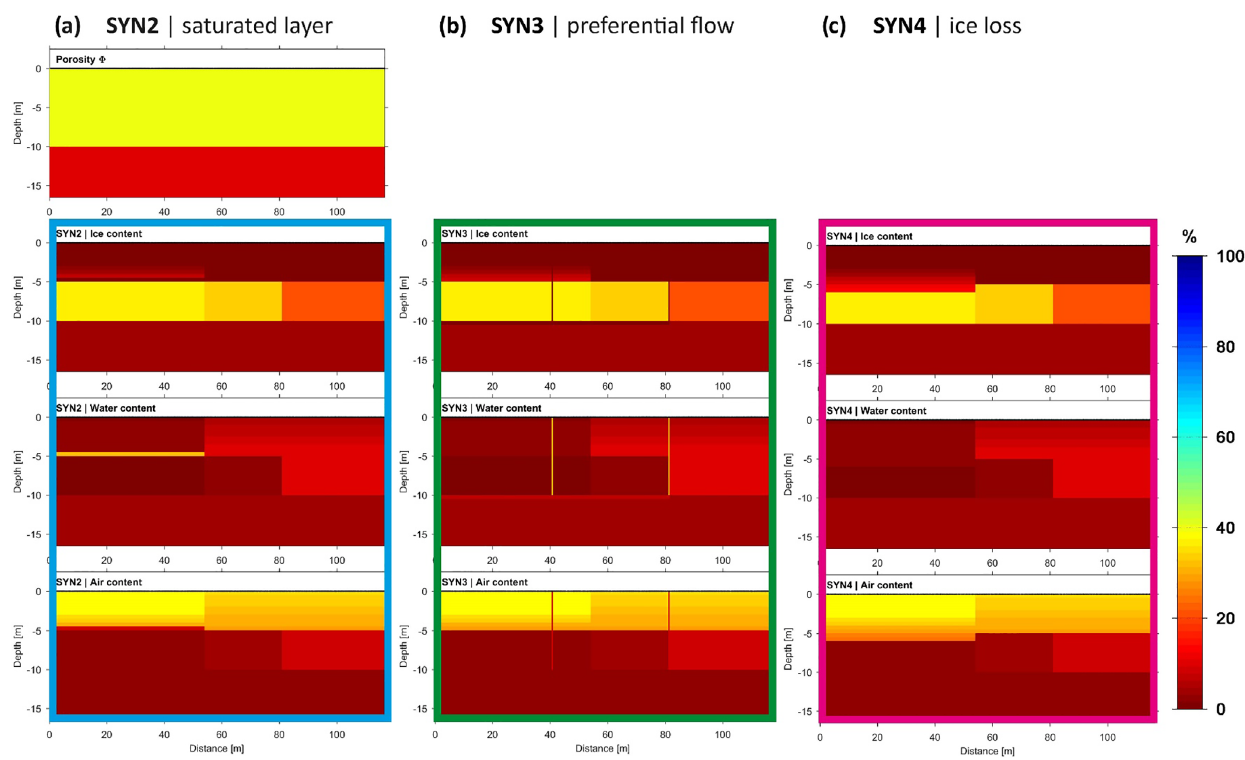
Figure 6. 4PM results for the synthetic model scenarios (see Fig. 4a, b). The blue, green and pink rectangles correspond to the same rectangles in Figs. 4, 5 and 7. The prescribed porosity model is shown in the uppermost panel.